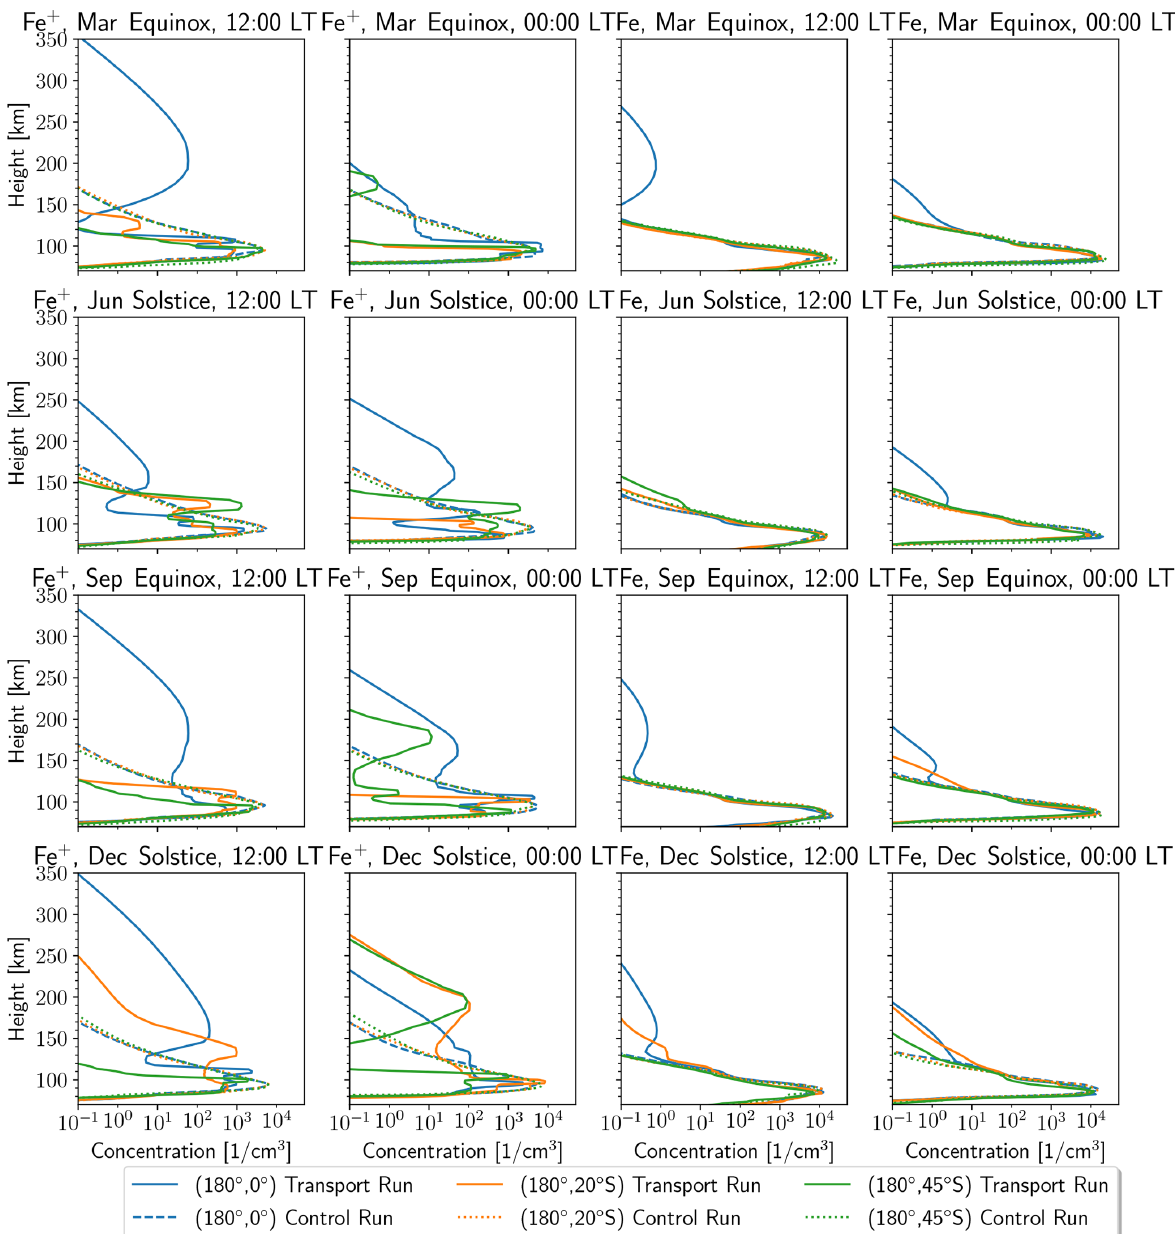
Figure 5. Comparison of the vertical profiles of the Fe + (left two panels) and Fe (right two panels) number densities, for the control run (dotted/dashed lines) and the run with ion transport (solid lines) over selected geographic latitudes, at the equinoxes and solstices and midday (12:00LT) and midnight